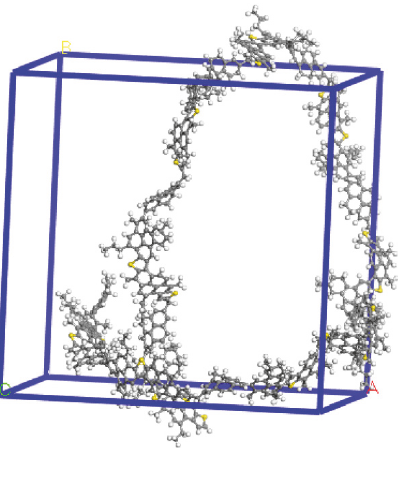
Figure 15: Ultimate model of